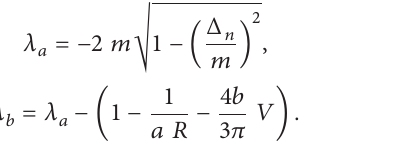
Figure 7: Phase portrait of system (6) with 𝑏 + 𝑎 = −1.81 mA / V and Δ 𝑎 nl in = 0.1 , (𝑉,𝜃) = (1.02 V , 22.2 ∘ ) is a stable node with 𝜆 Δ 𝑛